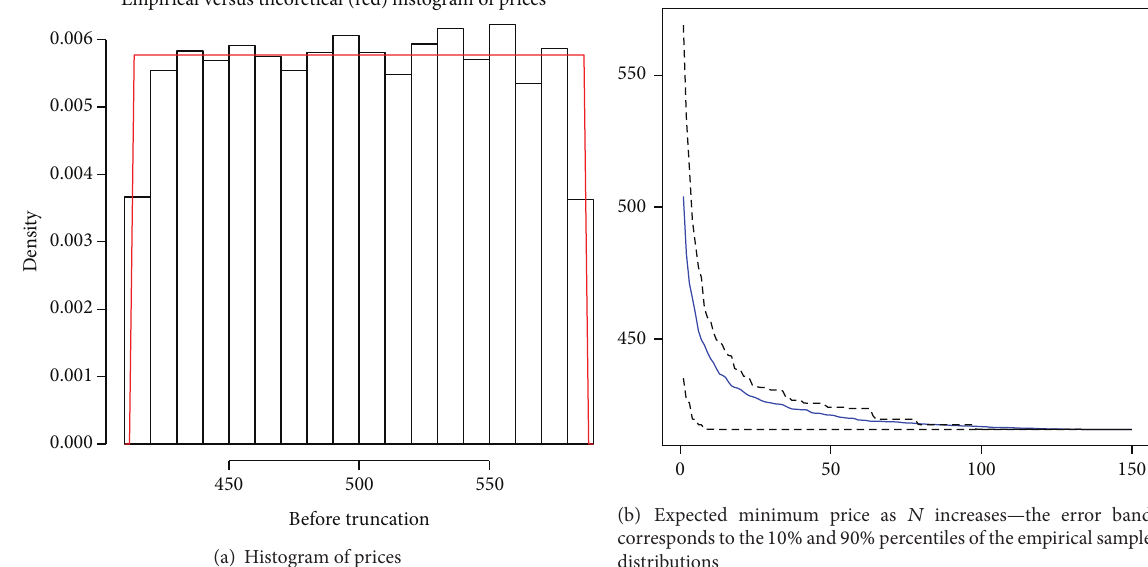
Figure 3: Price distribution and expected minimum prices, case of uniform distribution with mean 𝜇 = 500 and standard distribution 𝜎 = 50 .